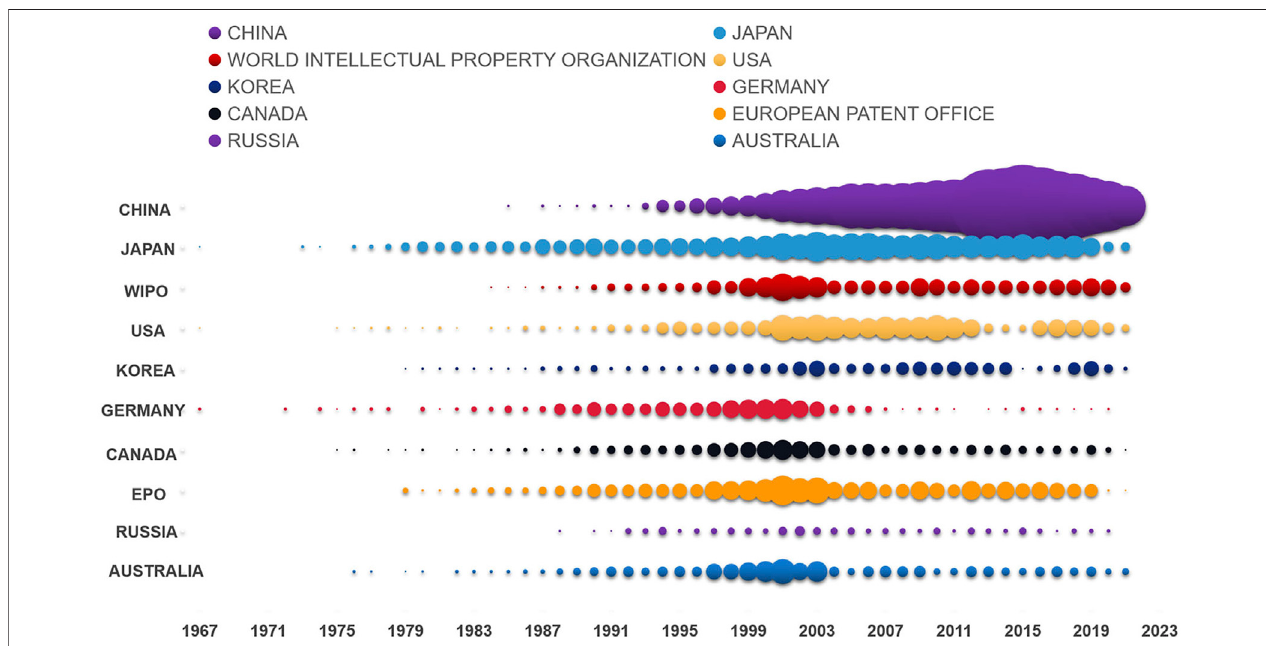
FIGURE 3 | Annual patent application trend of the top 10 countries or organizations in the number of anticancer natural product patent applications. Patent applicationsbeganinJapan,theUnitedStates,andGermany.Thebubblesinthe fi gurere fl ecttheevolutiontrendofthenumberofpatentapplicationsofeachcountryor organization in the time